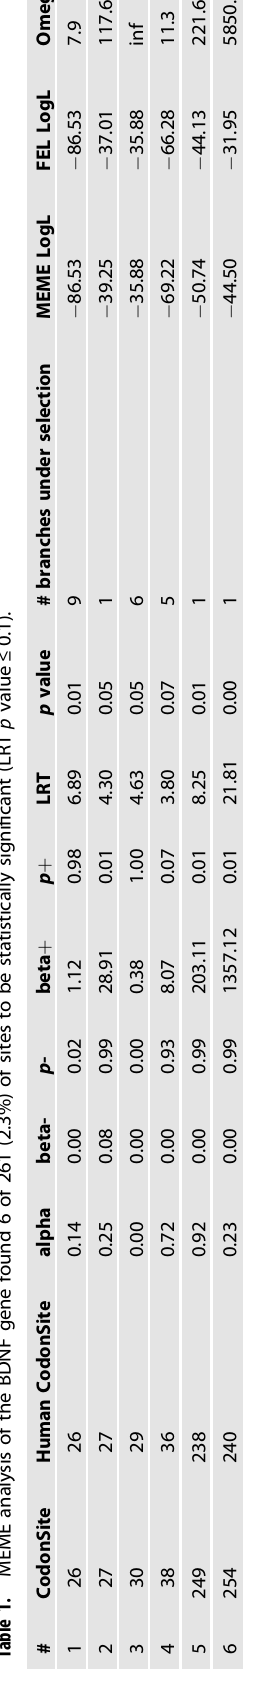
Fig. 2) BDNF protein structure. Alternatively, this data may be evidence that coevolving sites may be related to other fi tness consequences (e.g., compensation) for maladaptive changes in another part of the protein sequence that may have occurred. When we review these sites, we notice that several pairs (see Fig. 2) occur within alignment sites, which correspond to the Human BDNF coordinate system (Table 1). These include pair-sites of (89, 184), (94, 155), (103, 233), and (135, 154). Of note, several other sites also display interesting geometric features including triangular relations [(81, 93), (93, 98), and (81, 98)], an acyclic graph network of site